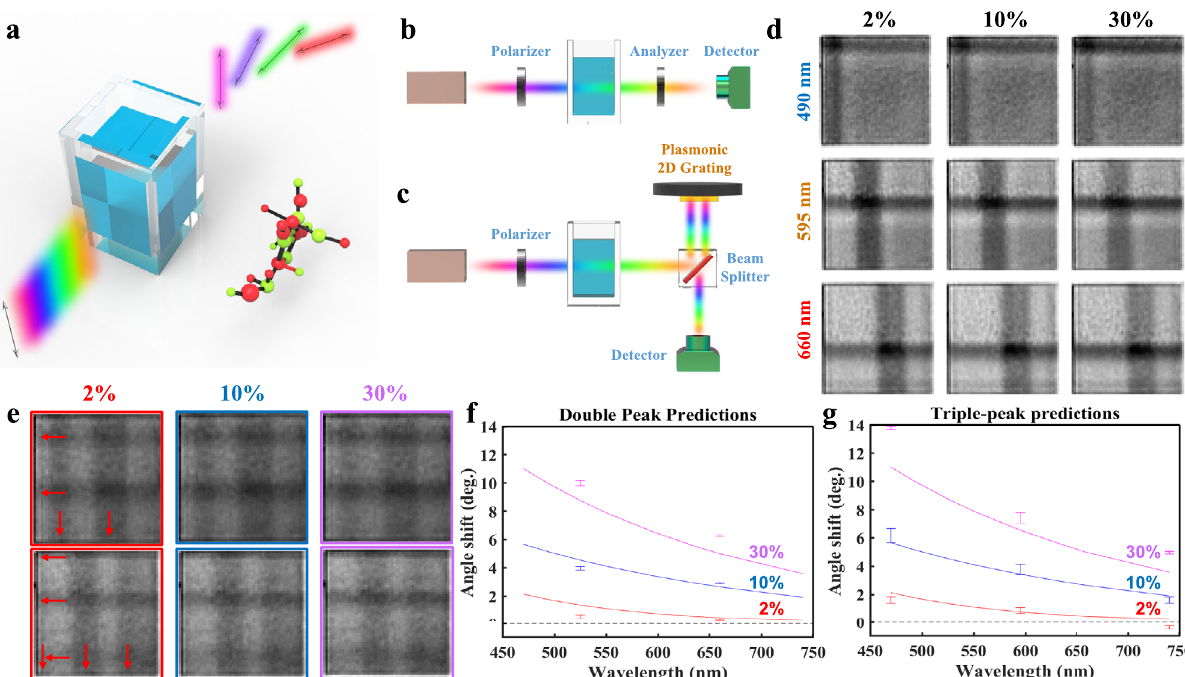
Fig. 5 | Simpler, accurate, and intelligent spectropolarimetric analysis. a Illustration of optical rotatory dispersion when light passes through a chiral substance such as glucose. b, c Setups for spectropolarimetric analysis using b a traditional system and c our proposed image-based graded grating system. Our proposed system replaces the second polarizer (analyzer) from the conventional system with a beam splitter and our plasmonic grating. A CCD camera captures images of the plasmonic grating re fl ection mode, in which the cross-bar patterns appear as a set of dark bars formed from the coupling of light with the grating. d Images of the darkbar patterns under single-peakillumination, for 490,595, and 660nm illumination with 0% (DI water), 10%, and 30% glucose solutions. Although